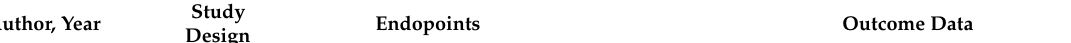
Table 1. Cohort Studies